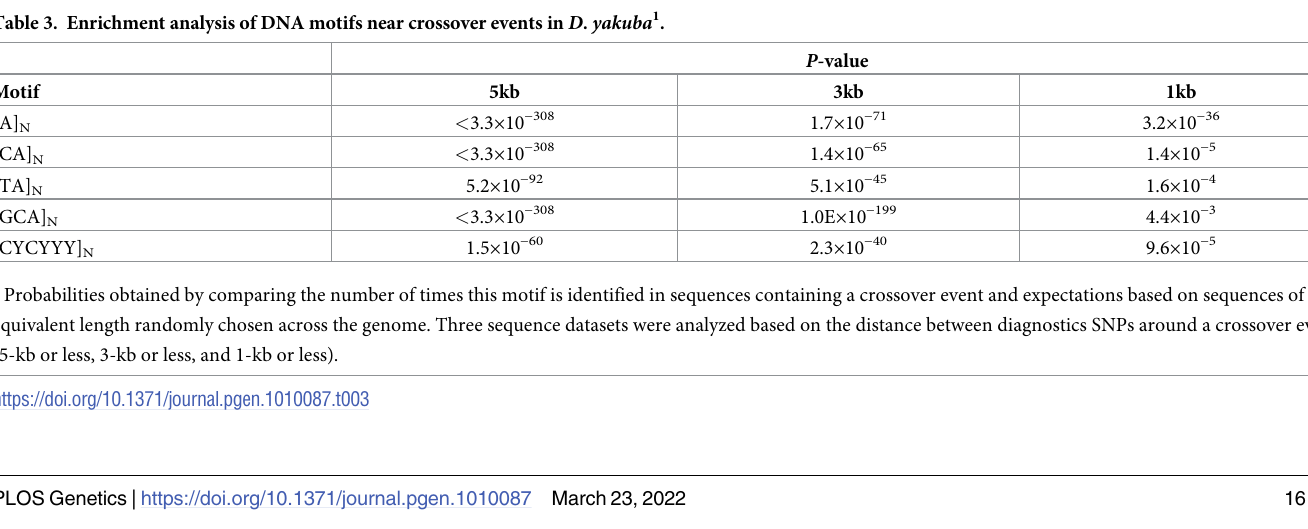
Table 3. Enrichment analysis of DNA motifs near crossover events in D . yakuba 1 .